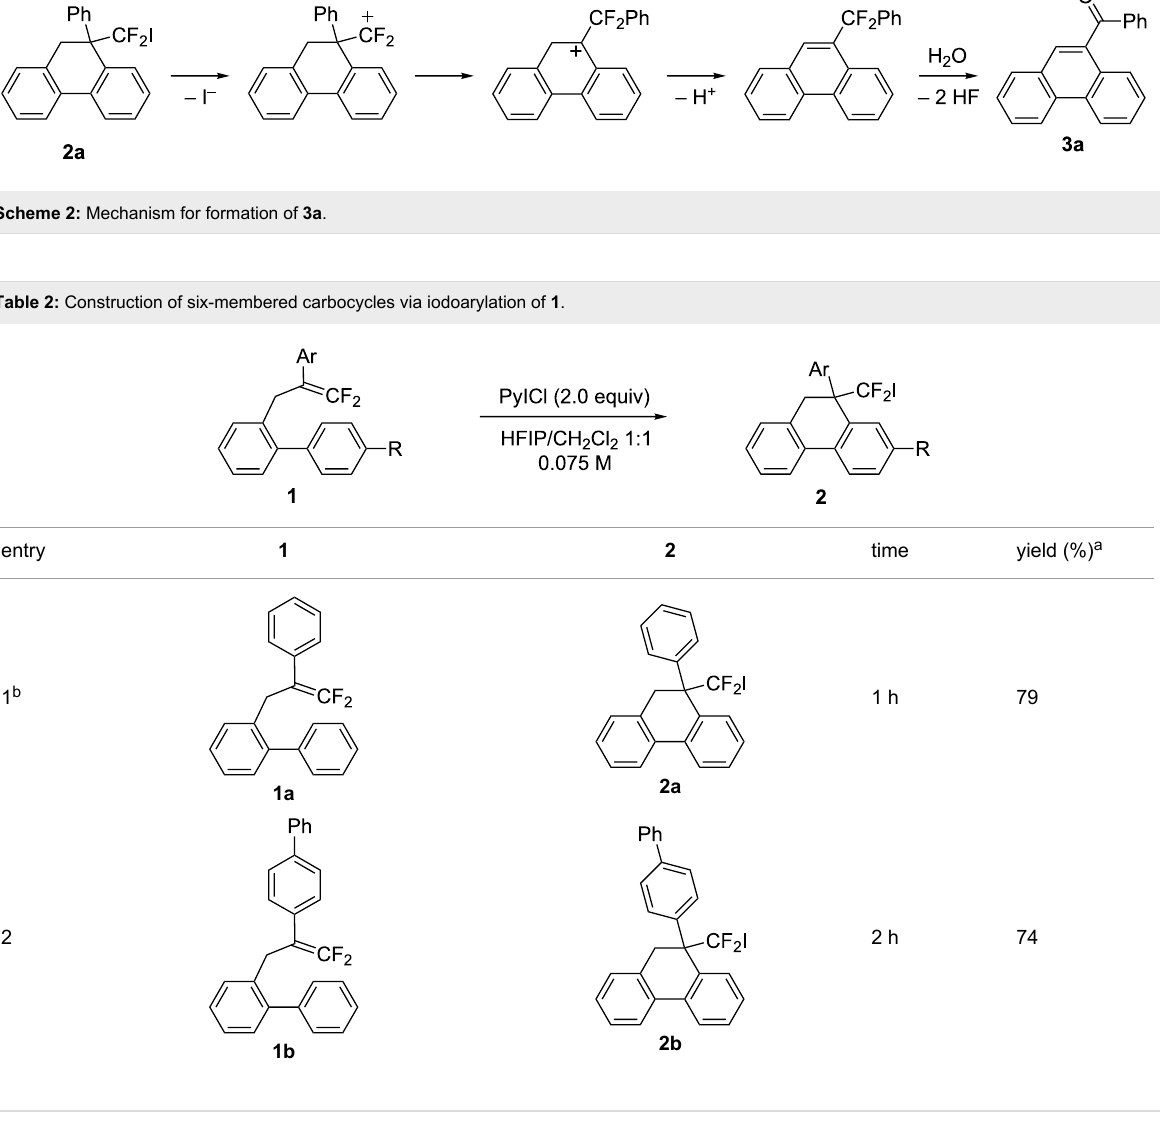
(Table 1, entry 5). The use of a 9:1 mixed solvent of HFIP and CH 2 Cl 2 improved the yield of 2a to 85%